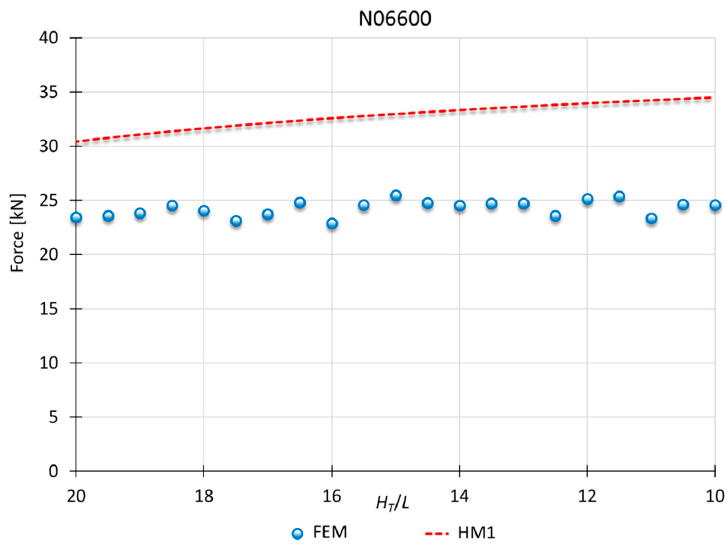
Figure 14. MUBT-FEM comparison for N06600, n = 0.20.